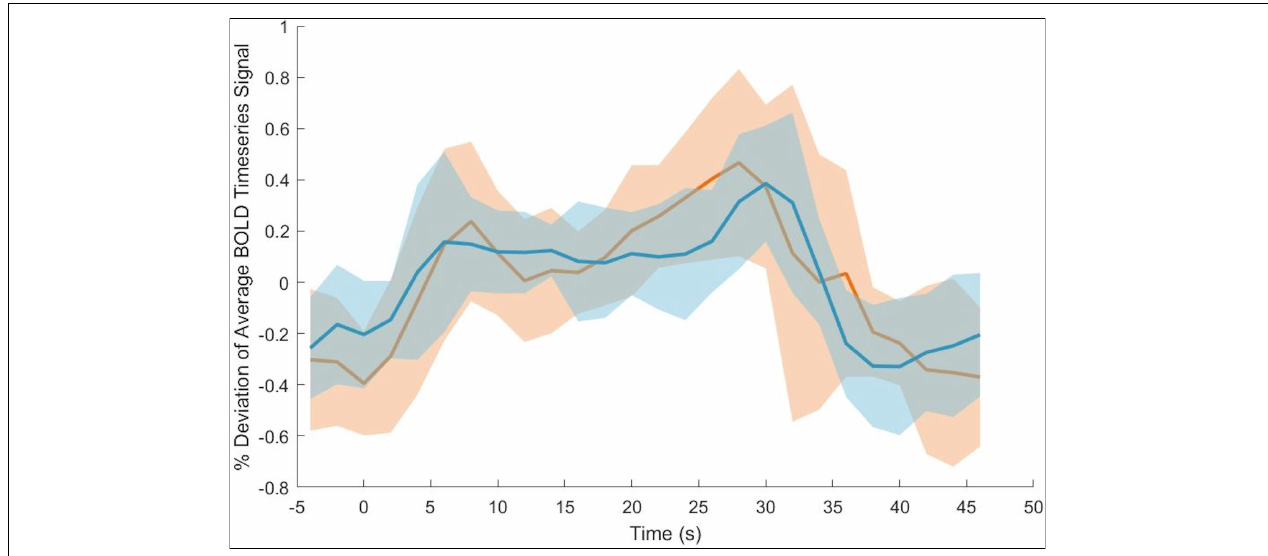
FIGURE 3 | Average across ROI voxels with subtracted mean BOLD signal intensity for baseline (orange) and endpoint (blue). Group level standard deviation plotted around timepoint BOLD signal intensity means. Time at 0 s represents the stimulus onset time. Note that the standard deviation is greater at baseline than endpoint.